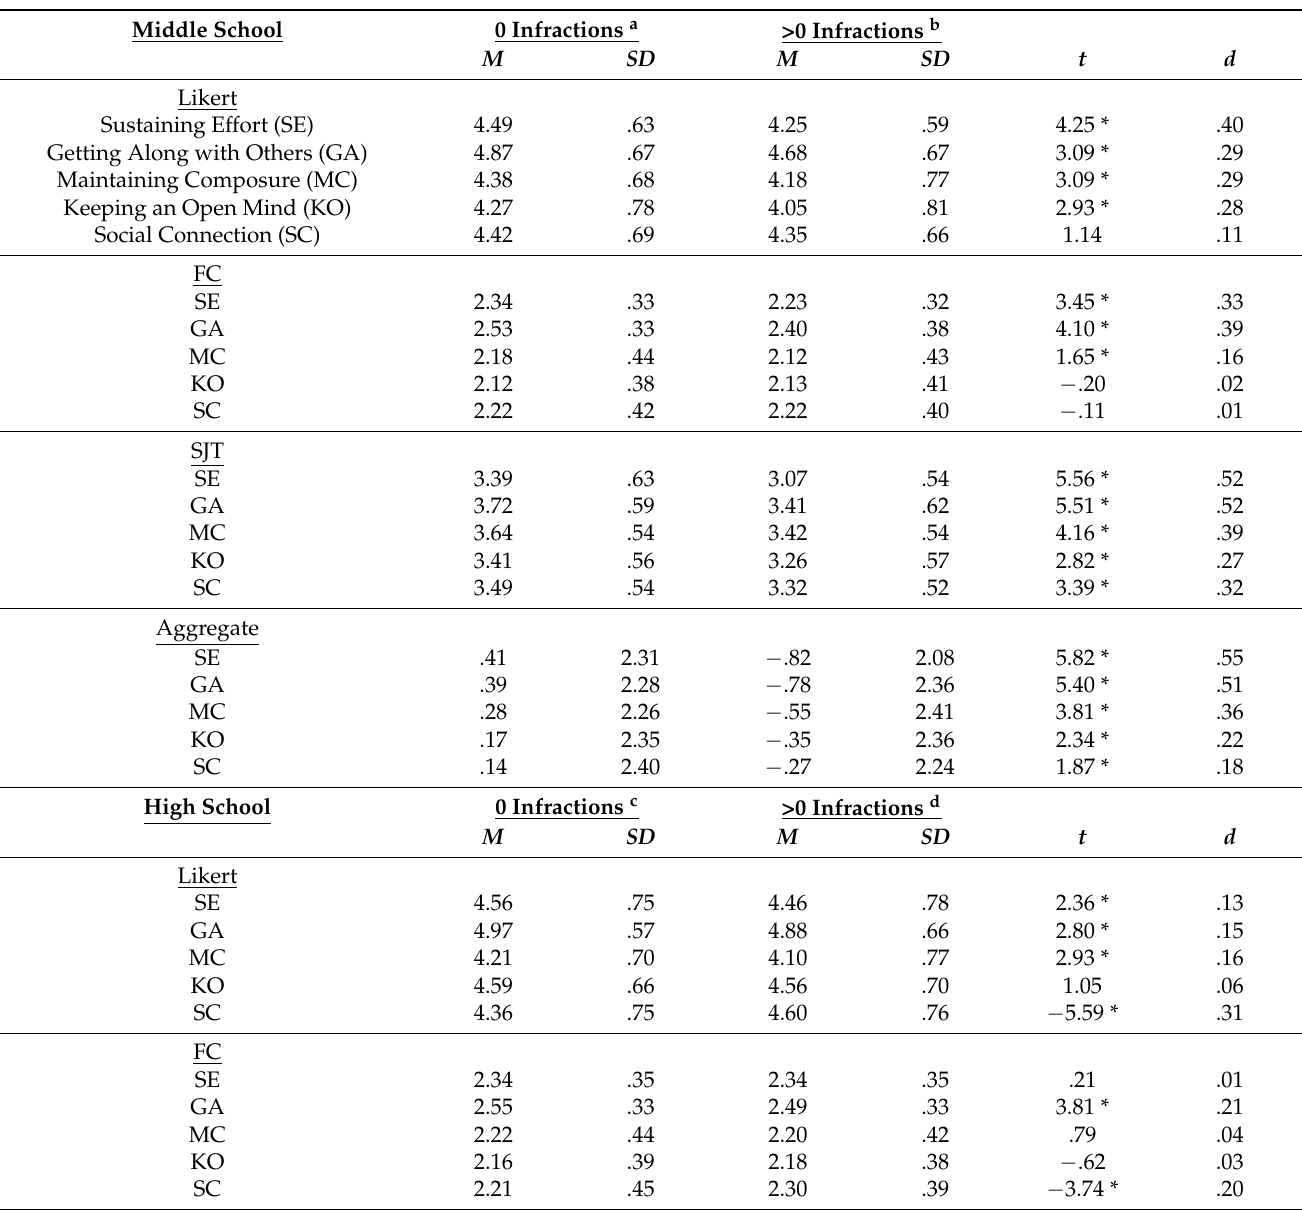
Table 5. Mean Differences on Mosaic Skills Between Students with None and Some Discipline